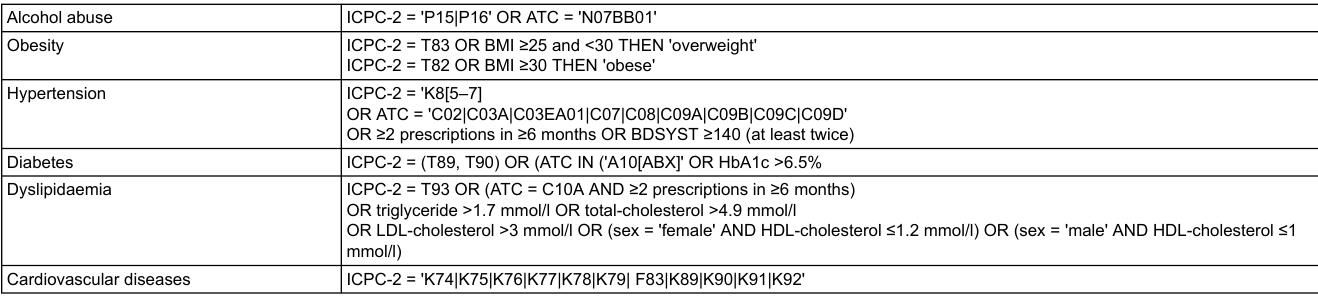
Table S1: Details of definitions to identify comorbidities.